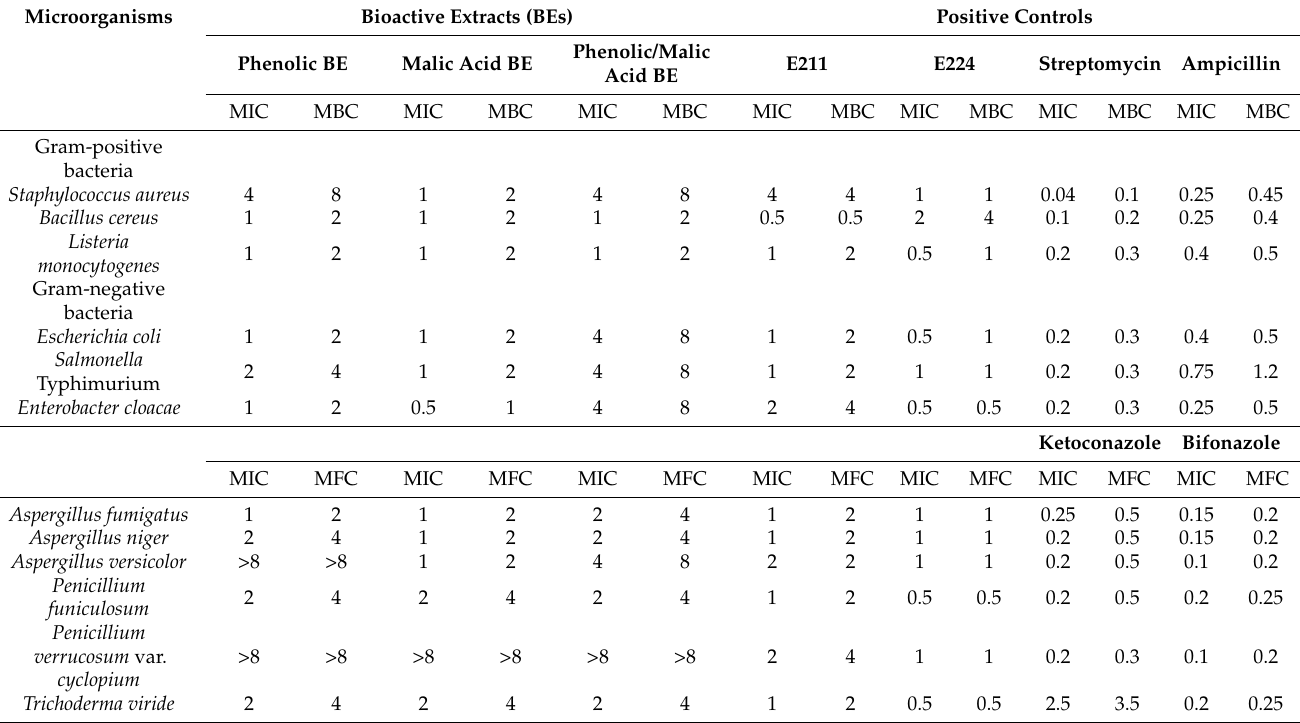
Table 6. Antibacterial and antifungal activity of phenolic, malic acid, and phenolic/malic acid- enriched quince peel bioactive extracts (BEs) and positive controls (sodium benzoate (E211), potas- sium metabisulfite (E224), streptomycin, ampicillin, ketoconazole, and